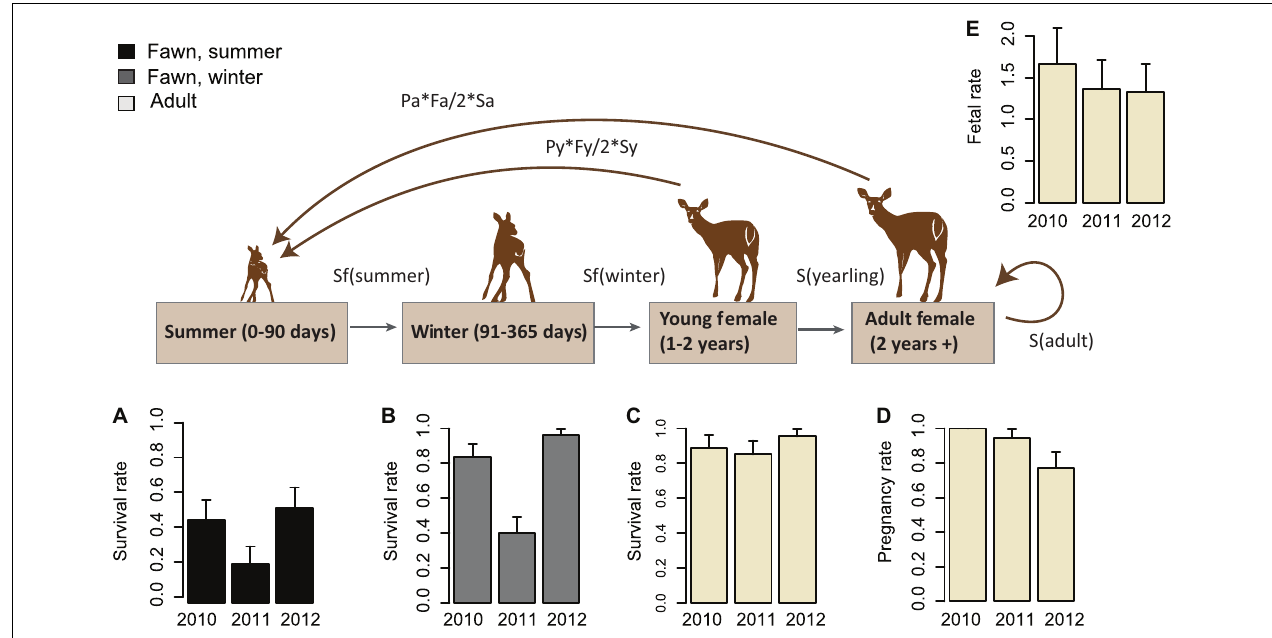
FIGURE 3 | Interannual variability in vital rates throughout the life cycle of Sitka black-tailed deer (monitored 2010–2013). Inter-annual variability in vital rates, with standard error bars, is shown for 2010–2012, comprised of (A) summer survival rate of fawns (0–90 days old); (B) winter survival rate of fawns (91–365 days old); (C) annual survival rate of adult females, (D) pregnancy rate of adult and yearling females, and (E) fetal rate of adult and yearling females. The study was conducted on Prince of Wales Island, AK, United